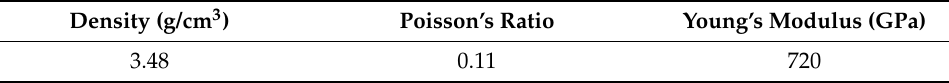
Table 4. The material properties of the CBN ball-end milling cutter